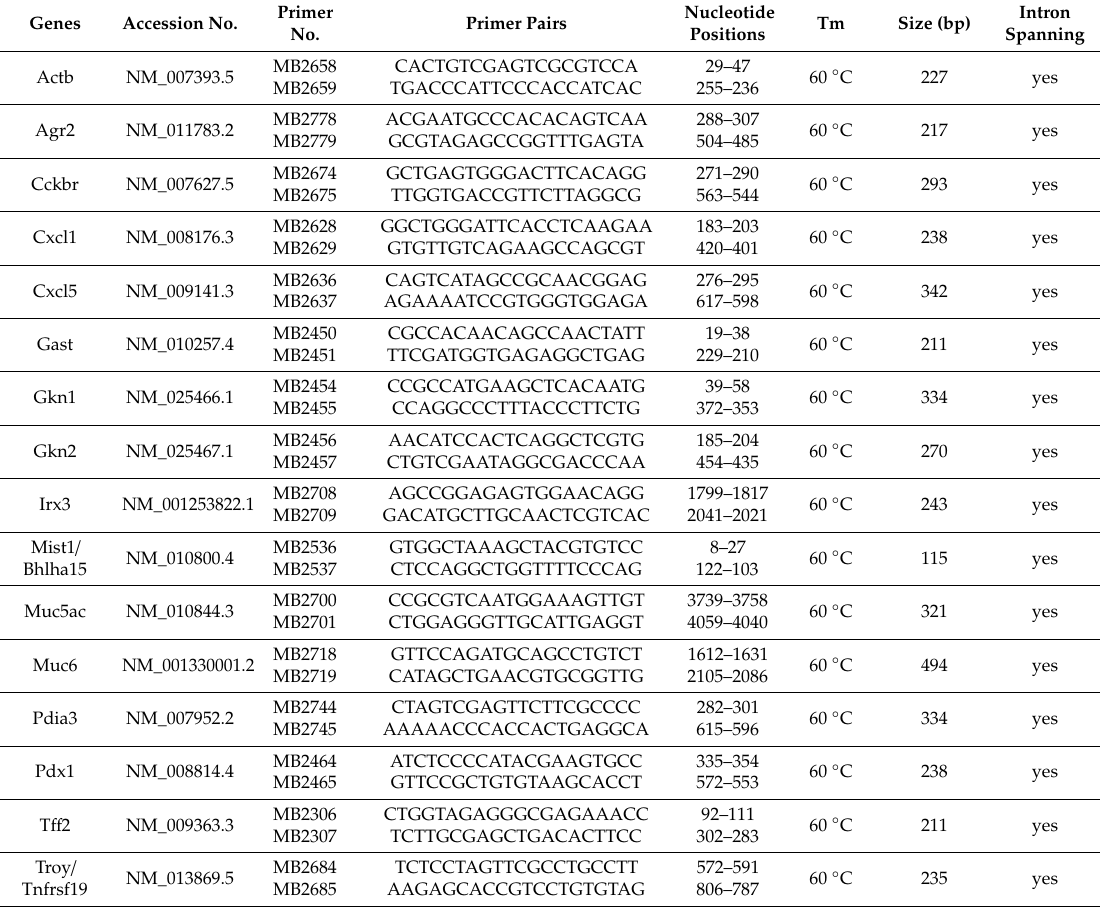
Table 1. Oligonucleotides used for RT-PCR analysis and calculated size of the